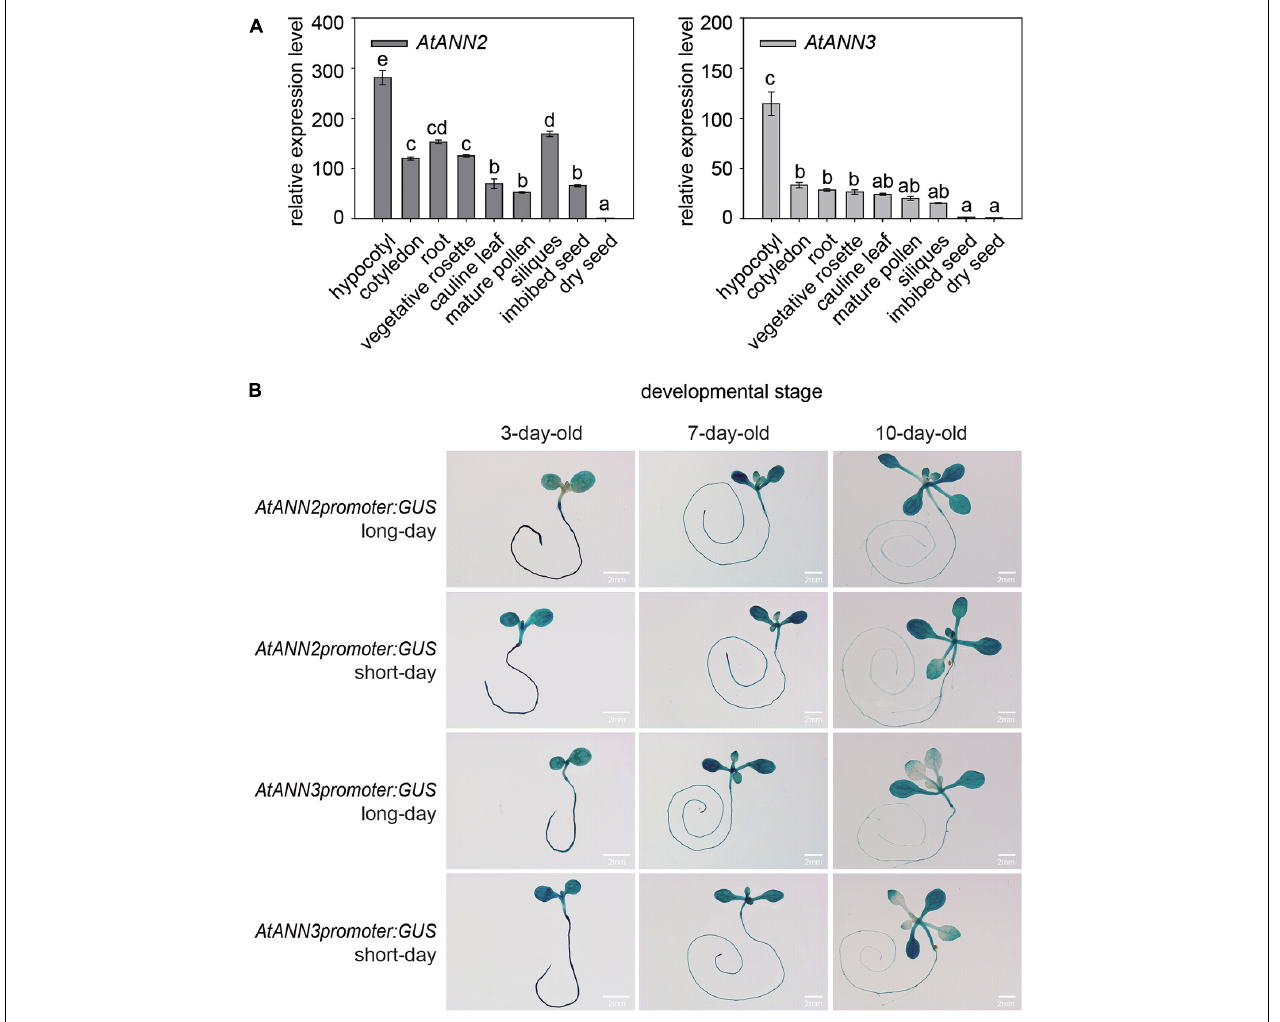
FIGURE 2 | Gene expression patterns of AtANN2 and AtANN3 in Arabidopsis seedlings under normal condition. (A) Gene expression patterns in different tissues using qRT-PCR analysis. (B) Gene expression patterns in developmental stages under long-day and short-day conditions using GUS reporter gene transgenic plants. Scale bar = 2